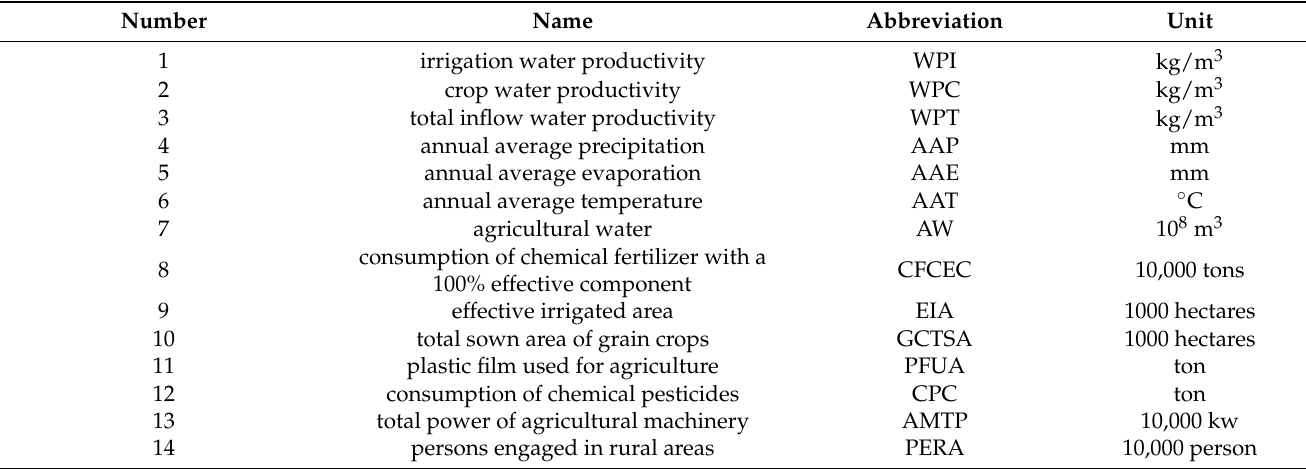
Table 1. Basic information of the indicators.